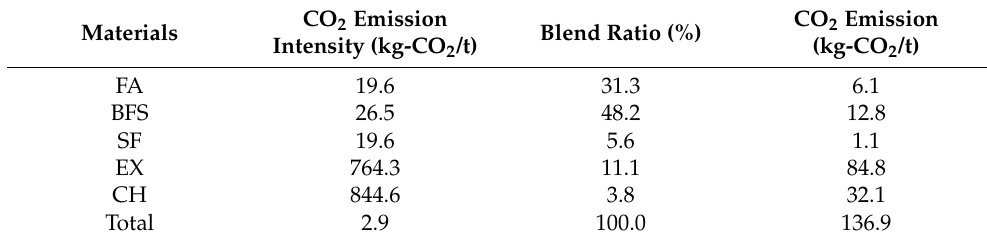
Table 11. Estimated CO 2 emissions of